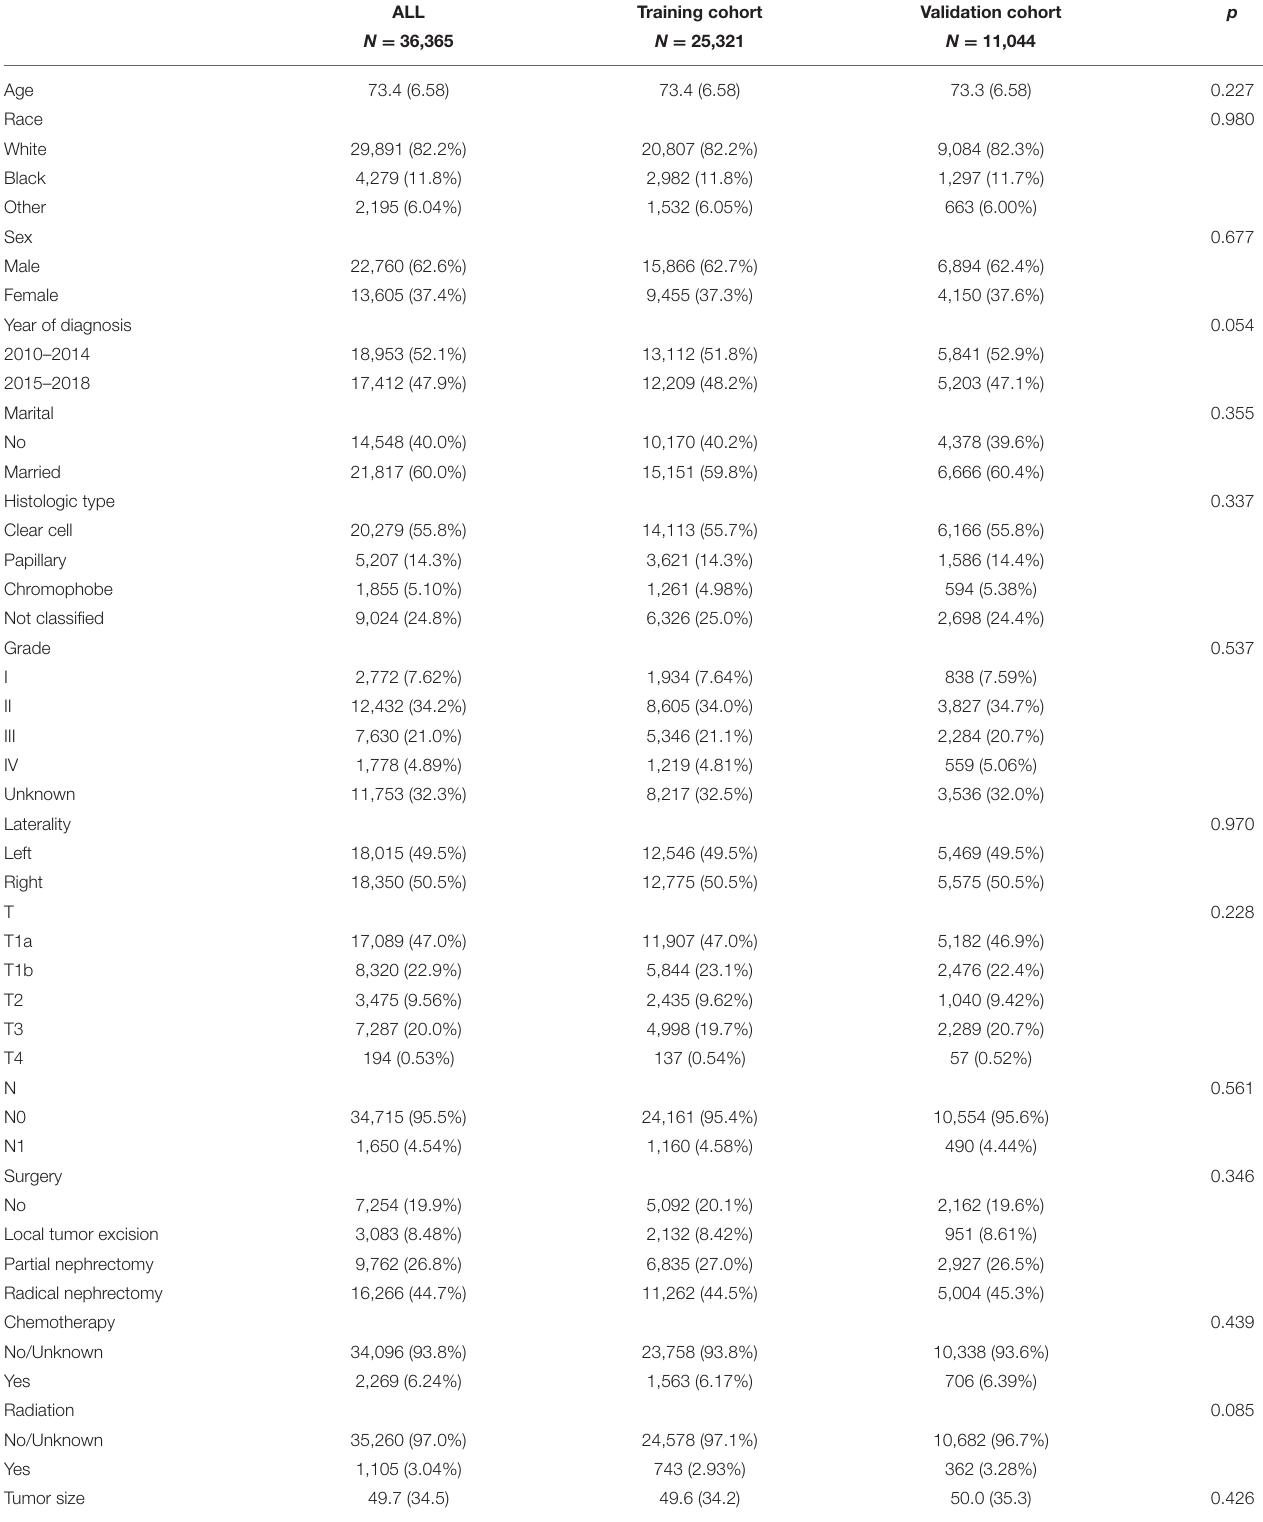
TABLE 1 | Clinicopathological information in elderly patients with renal cell